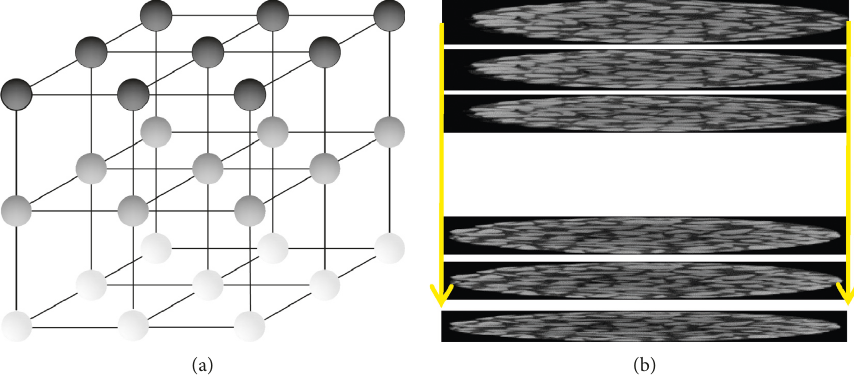
Figure 3: Three-dimensional unit net of CT gray image.